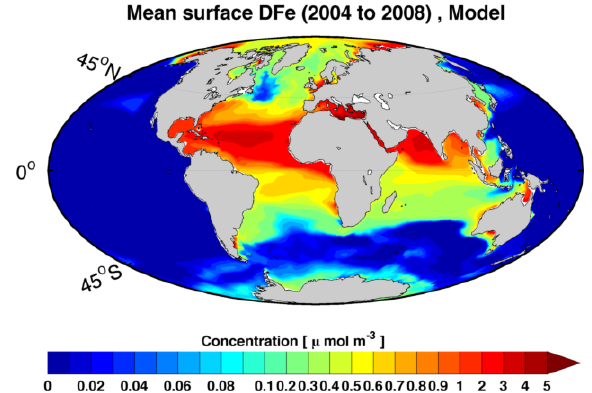
Figure 9. Spatial distribution of the mean surface concentration of dissolved iron. Plotted to the scale used by Schneider et al.